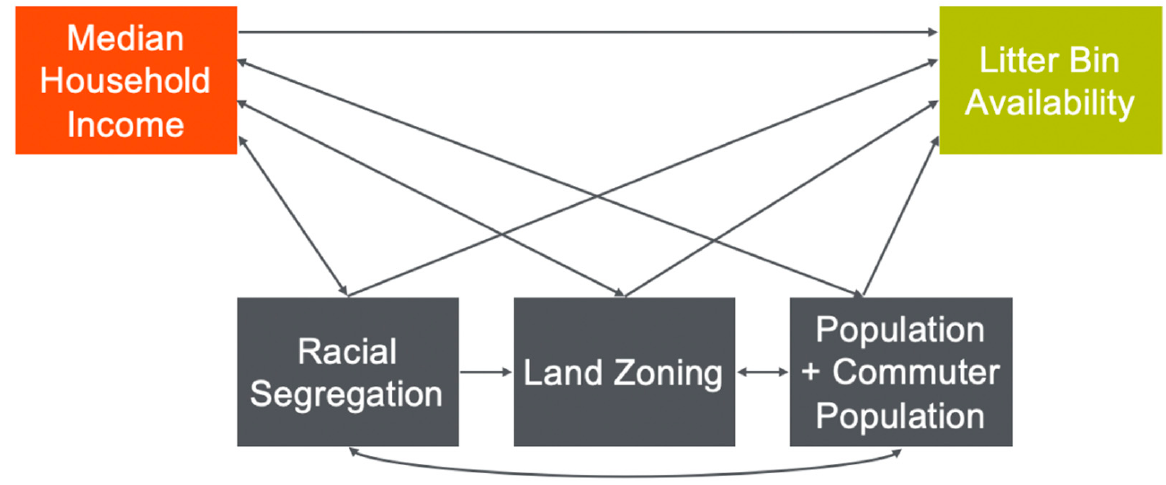
Figure 1. Theoretical framework.